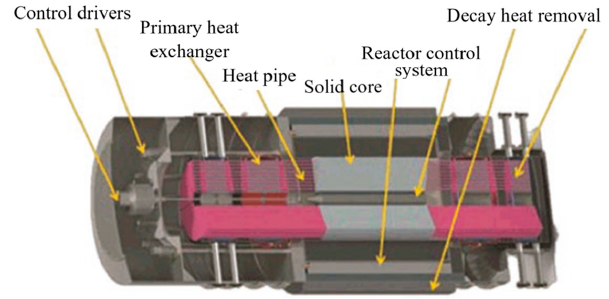
Figure 1. Layout of Westinghouse eVinci HPMR [10].